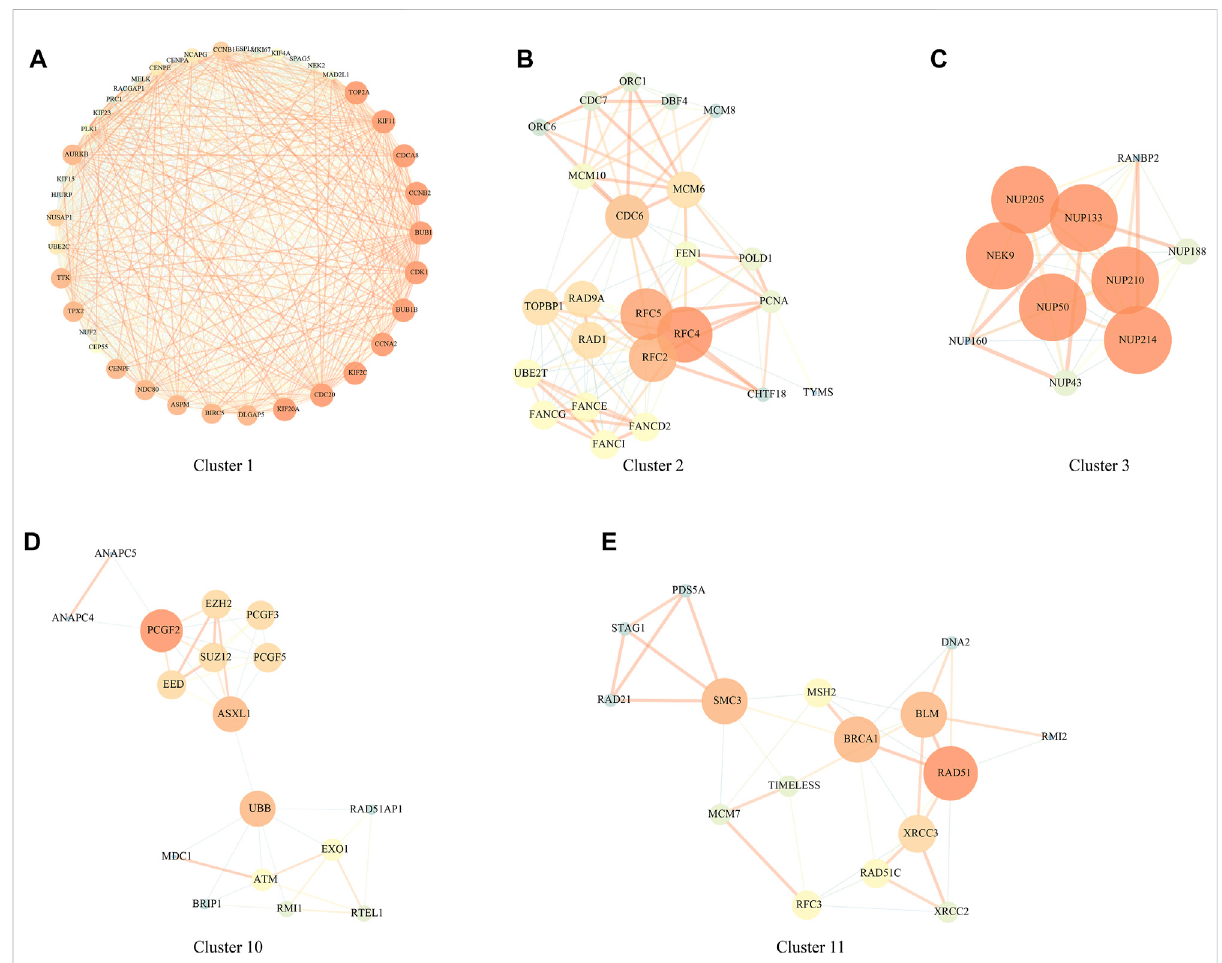
FIGURE 2 PPInetworkmoduleresults. (A) ClusteronenetworkPPIanalysis; (B) ClustertwonetworkPPIanalysis; (C) ClusterthreenetworkPPIanalysis; (D) Cluster 10 network PPI analysis; (E) Cluster 11 network PPI